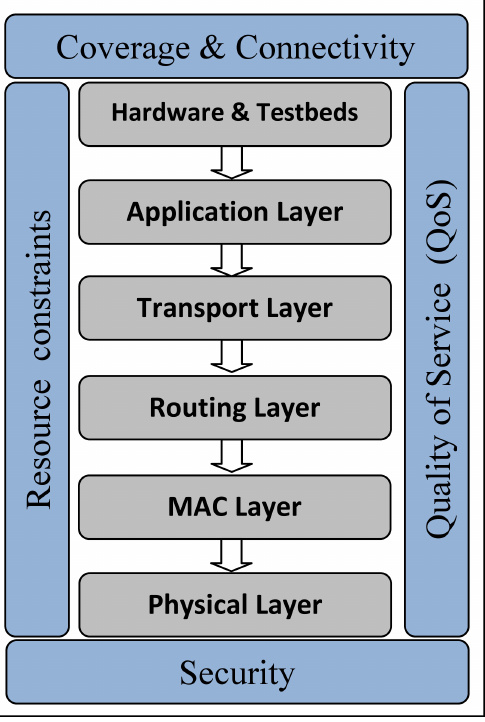
Figure 1. Research Challenges in